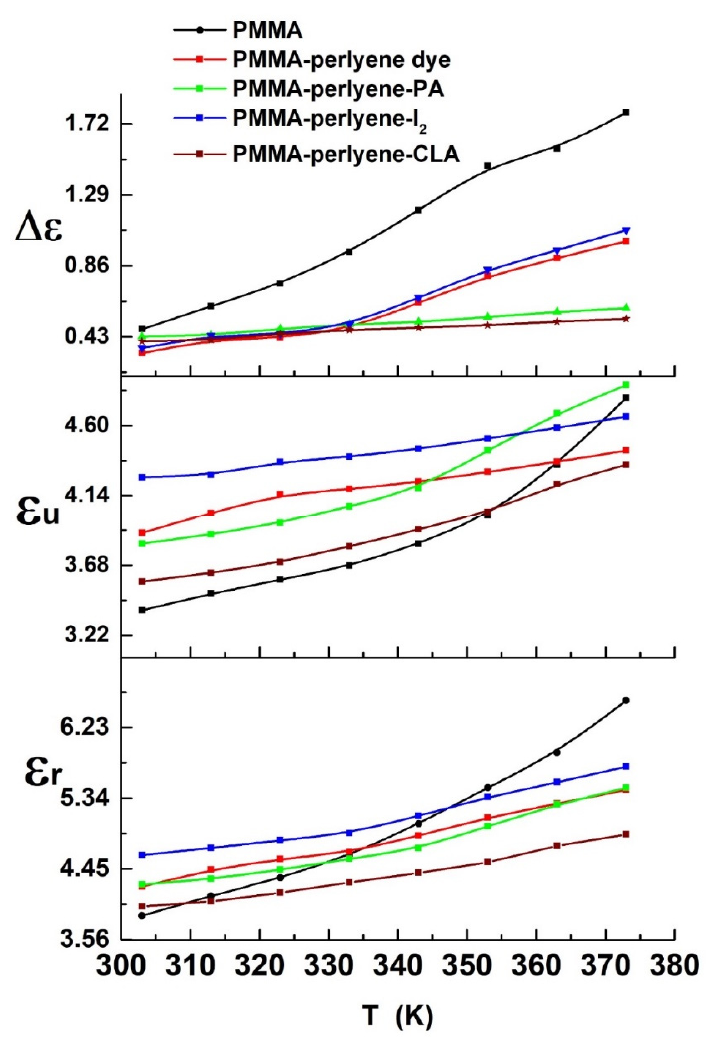
Figure 4. The temperature dependence of ε r , ε u and ∆ ε of the synthesized polymeric sheets. In general, dielectric losses exhibit a bell-shaped curve. The dielectric loss peaks for most polymers are asymmetric (distorted) and broad. The frequency dependence of ε 2 at different temperatures for the polymeric sheets are shown in Figure 5a–e. For temperatures below 353 K, a broad second dielectric relaxation peak appears in ( ε 2 ) for all polymeric sheets corresponding to the β relaxation. The magnitude of the maximum height of the β peaks are temperature independent. The intra molecular fluctuations may be the source of β relaxation that is affected by partial rotation of the side group around the bond, linking it to the main chain (heterogeneous local environment) [32,33]. For temperatures above 353 K, two peaks of dielectric relaxation appear in ε 2 for all polymeric sheets corresponding to the α and β relaxation. α relaxation is associated to the glass transition of the polymer and refers to cooperative transitions. The experimental relaxation behavior of the above results can be described by the